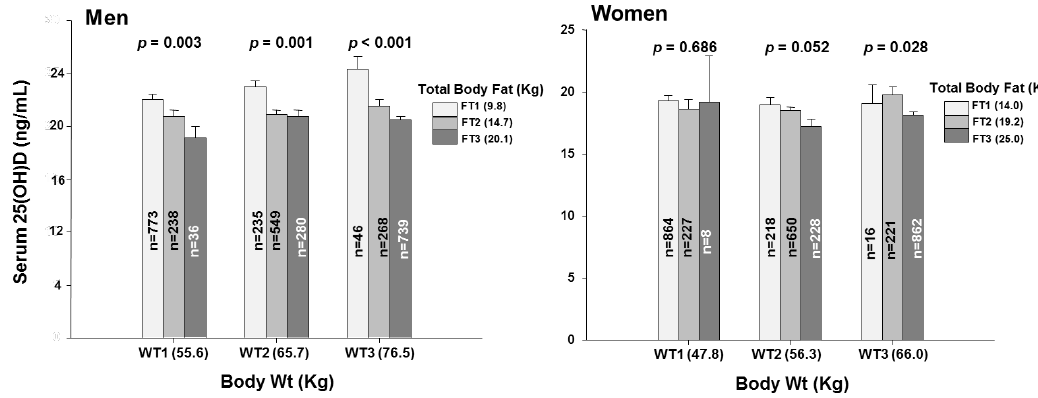
Figure 3. Serum 25-hydroxyvitamin D concentrations by total body fat tertiles within each body weight tertile categories. 25(OH), 25-hydroxyvitamin D; WT1, the first tertile of body weight (55.6 Kg, 31.9–61.6 Kg for men and 47.9 Kg, 32.3–52.7 Kg for women); WT2, the second tertile of body weight (65.7 Kg, 61.7–69.8 Kg for men and 56.3 Kg, 52.8–59.8 Kg for women); WT3, the third tertile of body weight (76.5 Kg, 69.9–108.6 Kg for men and 66.0 Kg, 59.9–100.0 Kg for women); Bar plots in which each total weight tertile categories represent tertiles of total body fat mass (FT1, the first tertile of total body fat mass, 9.8 Kg, 3.3–12.7 Kg for men and 14.0 Kg, 4.9–17.1 Kg for women; FT2, the second tertile of total body fat mass, 14.7 Kg, 12.7–16.5 Kg for men and 19.2 Kg, 17.1–21.4 Kg for women; FT3, the third tertile of total body fat mass, 20.1 Kg, 16.5–36.2 Kg for men and 25.0 Kg, 21.4–46.8 Kg for women). Data plotted represent mean and standard deviation. p for trend in same groups are from general lineal model in complex data analysis. The same pattern was seen for truncal and for limb fat